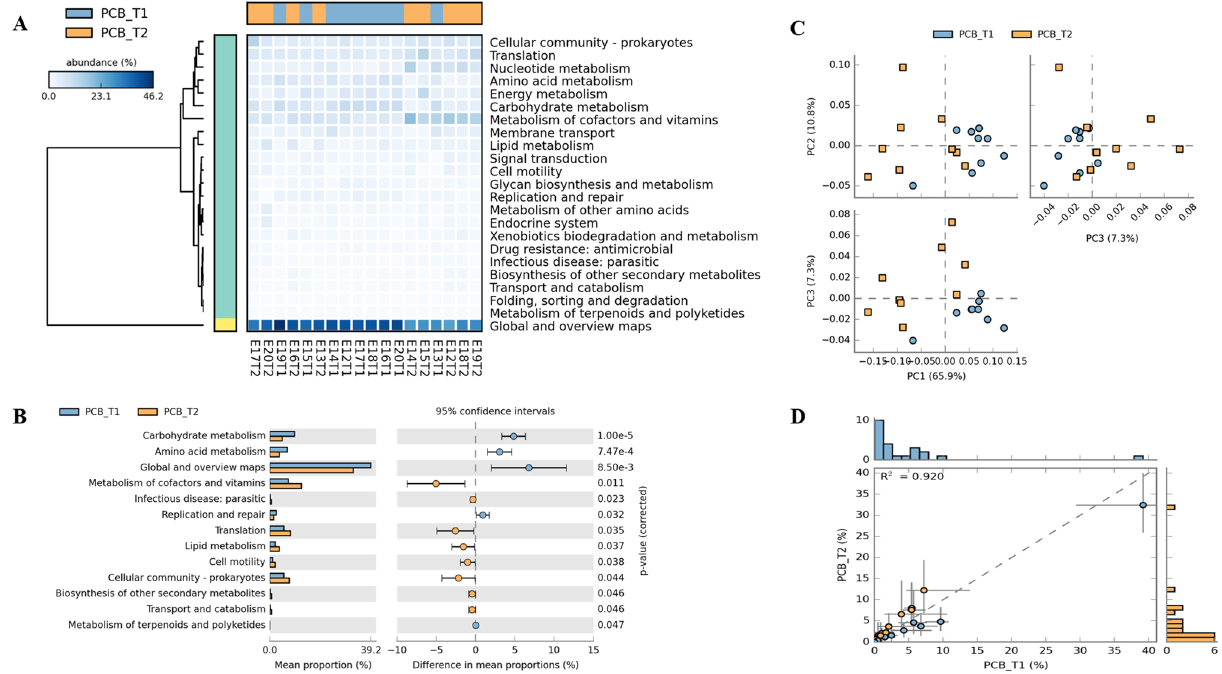
Figure 4. Metagenomic profile comparisons of metabolic pathways associated with PCB group members determined using STAMP analysis (Level-2). A - Expression of all altered pathways. B - Positive differences between proportions denote greater abundances in the PCB_T1 timepoint (blue), whereas negative differences between proportions show greater abundances in the PCB_T2 timepoint (orange) for the given pathways. Corrected p -values were calculated based on two-sided Welch’s t-test no correction and Welch’s inverted CI method. Difference with a p -value of < 0.05 were considered to be significant. C - PCA plot determined from the proportion of reads assigned to each pathway within a sample. D - Profile scatter plot with histograms showing the proportion of genes and functional profile, relative to all assigned genes, within the PCB group at both the time